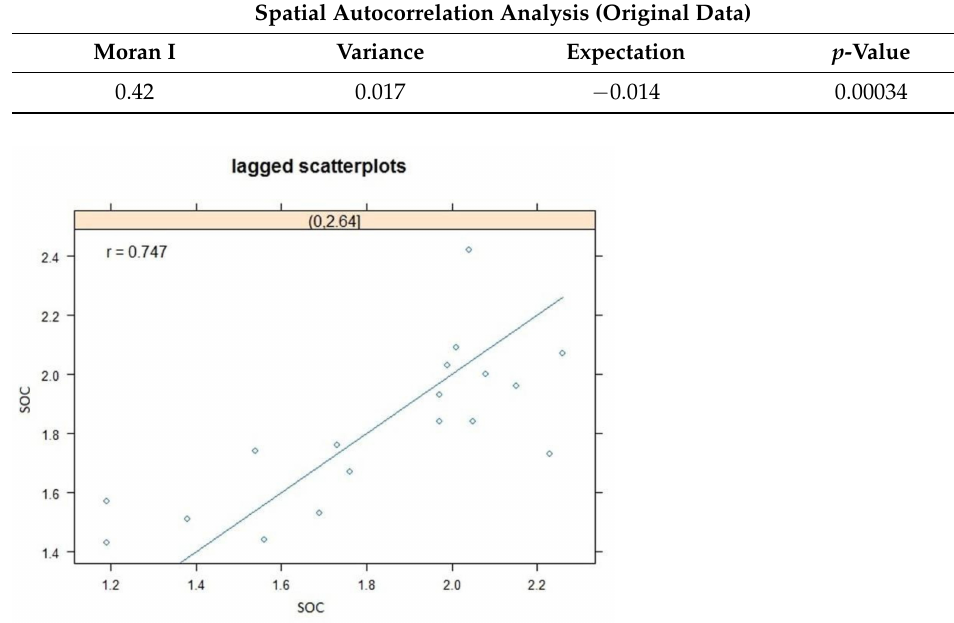
Figure 4. h-scatterplot for assessing local Moran I.